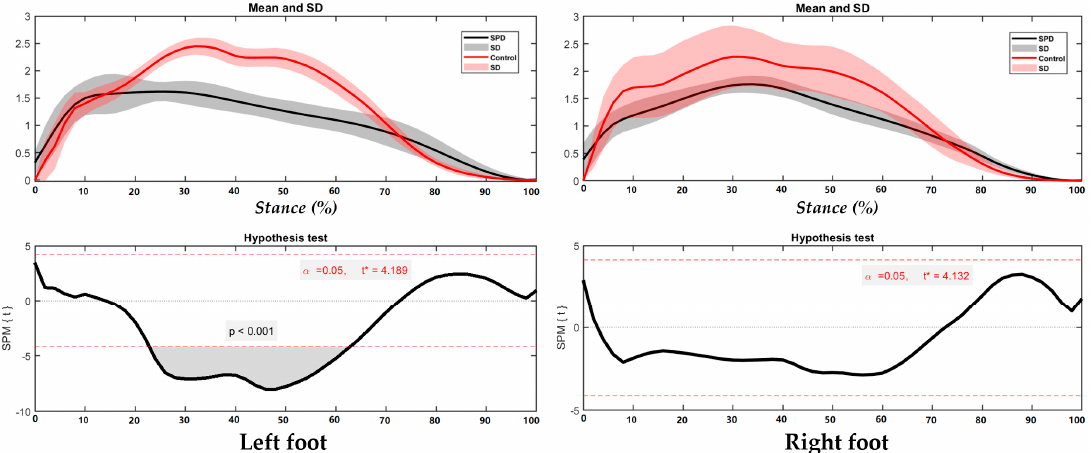
Figure 7. The vertical ground reaction force (GRF) in the left foot and right foot during running in SPD children and healthy controls (unit: Z avg ).